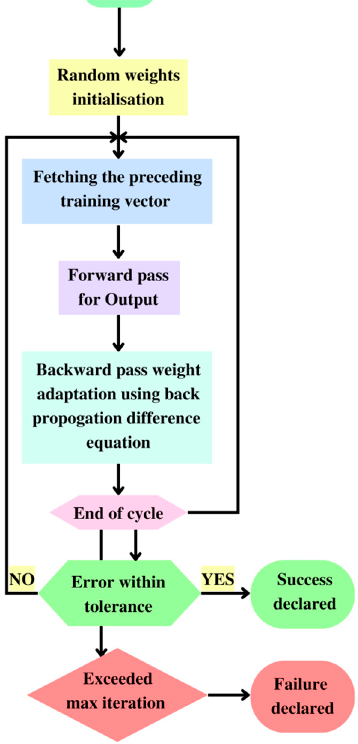
Figure 7. Algorithm for the back-propagation artificial neural network program. Back-propagation